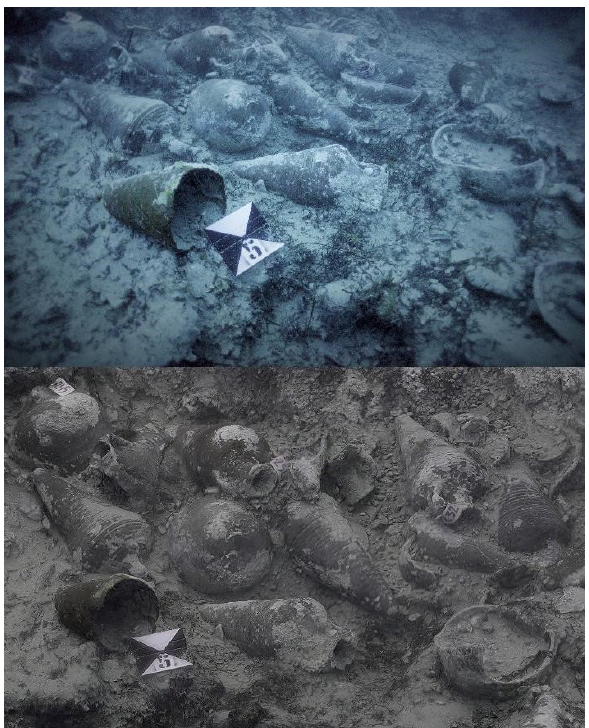
Figure 9. Same portion of the shipwreck: above, underwater image and, below, 3D